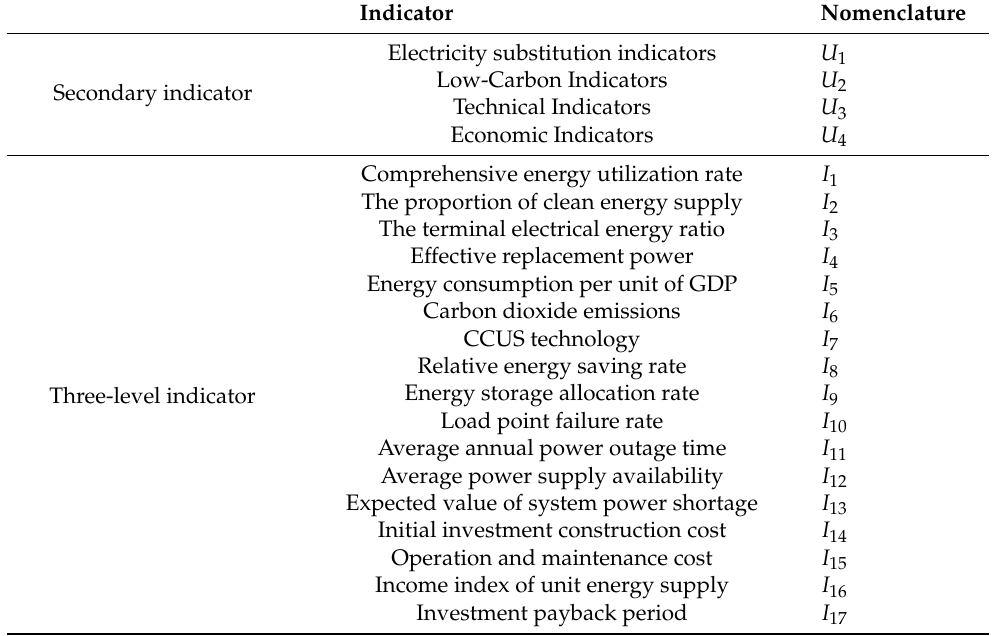
Table 3. Index name and its nomenclature.